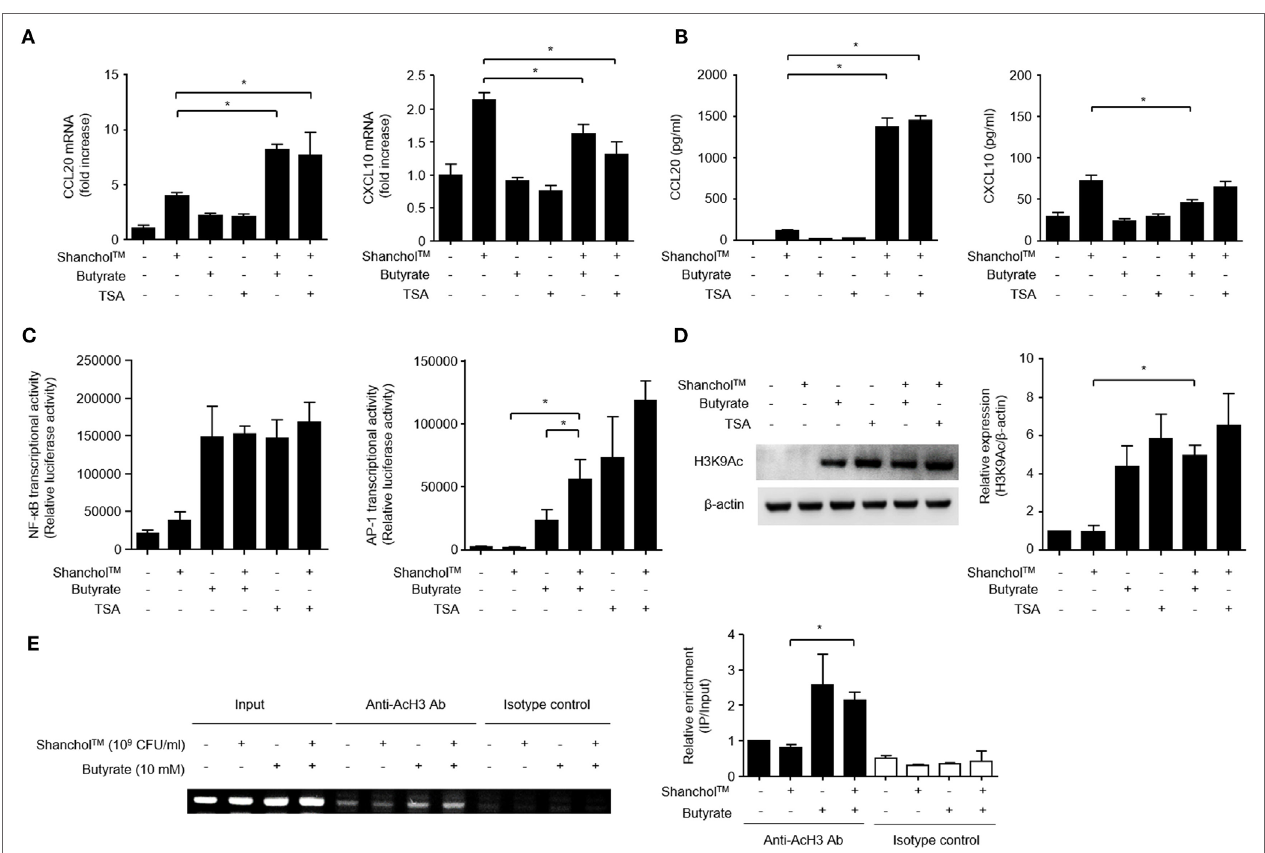
FigUre 5 | Histone deacetylase inhibition is necessary for CCL20 production in Caco-2 cells. (a) Caco-2 cells were stimulated with Shanchol ™ in the presence of 10 mM butyrate or 5 µM trichostatin A (TSA) for 3 h. Total RNA was isolated, and the mRNA expression level of CCL20 or CXCL10 was determined by real-time RT-PCR. (B) Caco-2 cells were treated with Shanchol ™ in the presence of 10 mM butyrate or 5 µM TSA for 24 h. Then, the culture supernatants were collected, and the concentrations of CCL20 and CXCL10 were determined by ELISA. All results are expressed as mean ± SD of triplicate samples. (c) Caco-2 cells transfected with a pNF- κ B-luc or pAP-1uc luciferase plasmid were further treated with Shanchol ™ in the presence of butyrate or TSA for 16 h. Then, the cells were lysed, and subjected to the luciferase assay. (D) Caco-2 cells were stimulated with Shanchol ™ in the presence of butyrate or TSA for 3 h. Cell lysates were generated and subjected to Western blot analysis to examine histone acetylation at lysine residues. The relative ratio of acetylated-H3K9 to β -actin was obtained by densitometry. (e) Caco-2 cells were treated with Shanchol ™ and/or butyrate for 2 h. Then, the cells were subjected to ChIP assay. Cross-linked chromatin extracts were immunoprecipitated with anti-acetylated histone H3 antibodies (Anti-AcH3 Ab) or rabbit IgG antibodies (Isotype control). DNA fragments were analyzed by PCR ( left ) and by real-time RT-PCR ( right ) using primers specific to the human CCL20 promoter. The results shown are representative of three independent experiments. Data are presented as mean ± SD of three independent experiments. The asterisk (*) indicates a statistically significant difference ( P < 0.05) compared with the appropriate